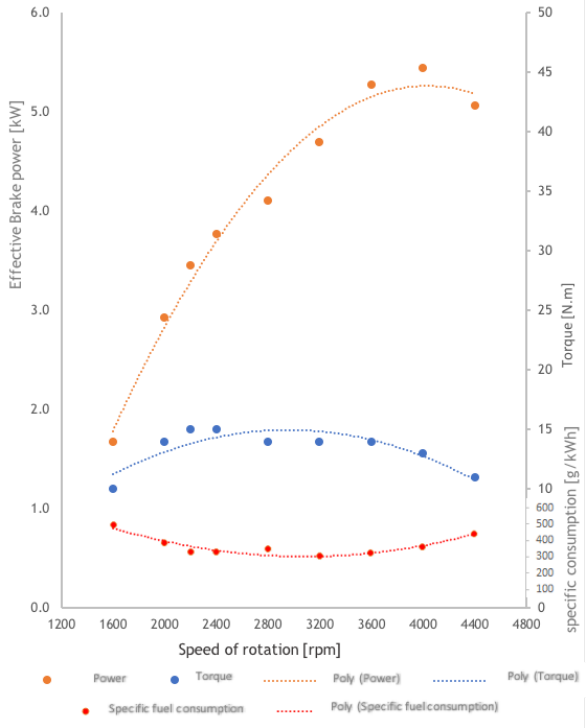
Figure 6: Characteristic curves of the engine.